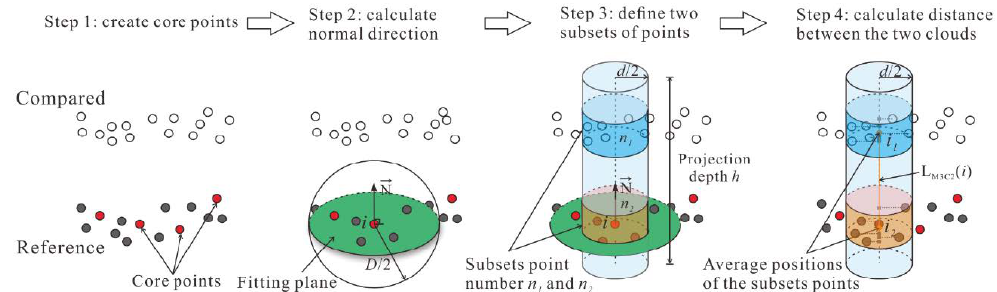
Figure 7. Cloud-to-cloud distance calculated by the M3C2